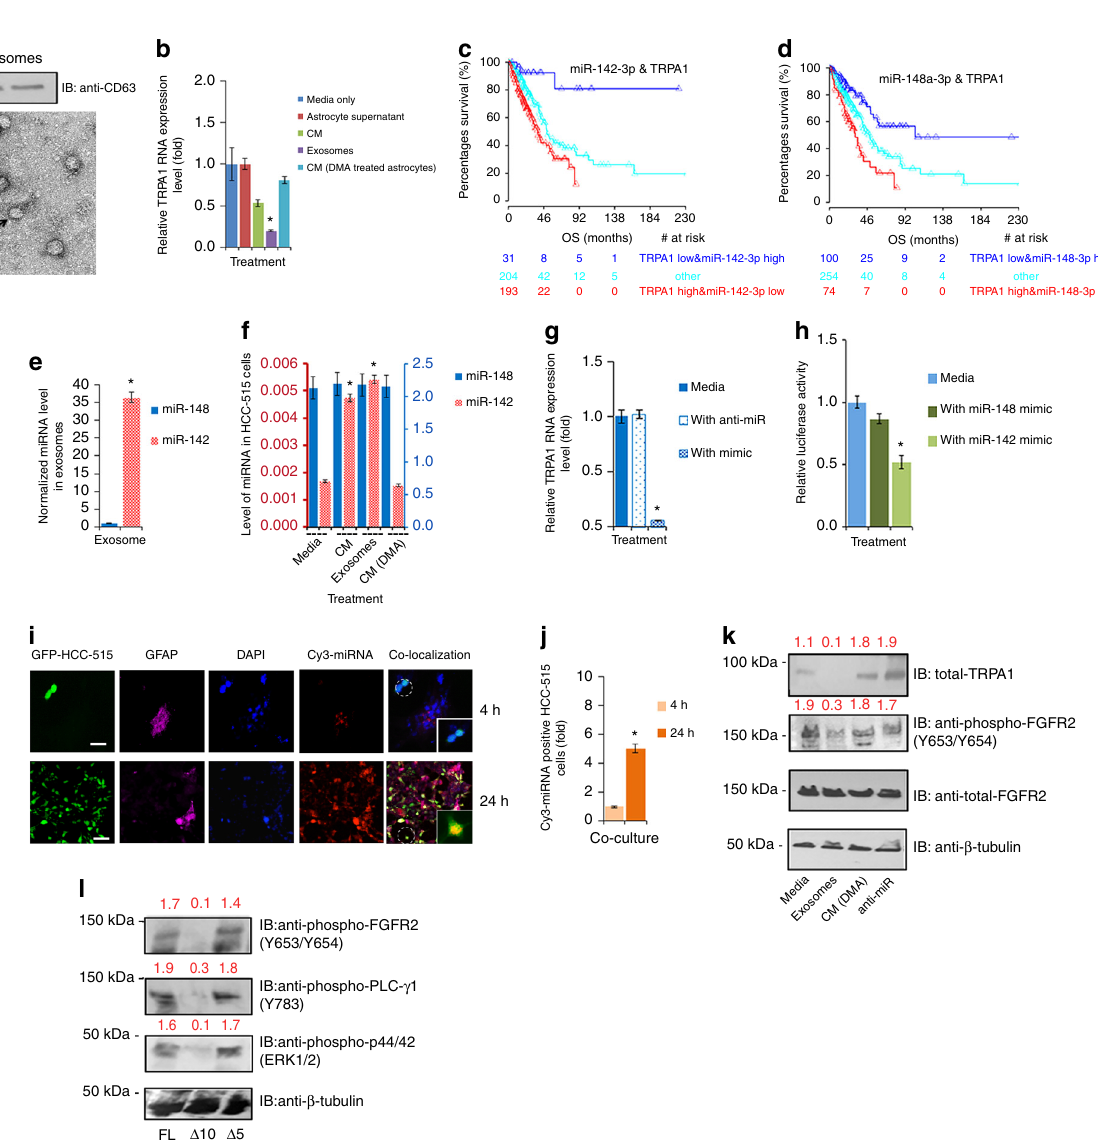
Fig. 6 TRPA1-targeting miR-142-3p is intercellularly transferred from astrocytes to HCC-515 cells. a TEM image (Scale bar: 50 nm) and western blot analysis (loaded samples are from two separate experiments) of puri fi ed exosomes. The blot was probed with CD63 antibody. b Bar graph depicting normalized TRPA1 mRNA level in HCC-515 cells treated overnight with SS media (normalization control), astrocyte supernatant, which lacks exosomes, astrocyte-CM, 200 μ l of 100X concentrated exosomes and CM from astrocytes that have been treated for 4 h with DMA (inhibitor of exosomal release). c , d Kaplan – Meier curve depicting the correlation of TRPA1, miR-142-3p, and miR-148-3p with patient survival. The numbers of patients at risk at different time points are presented at the bottom of the graph. The calculated log-rank test value yielded P = 0.00001 ( c ) and P = 0.00002 ( d ), respectively. The median of overall survival (OS) in months is shown. e , f Bar graphs showing the level of miRNA in exosomes and differentially treated HCC-515 cells. g Bar graph representation of the changes in TRPA1 mRNA levels in HCC-515 cells following their treatment with SS media only, SS media + anti-miR (miR-142- 3p inhibitor) and SS media+ miR-142-3p mimic. h Bar graph of the 3 ′ -UTR luciferase assay results obtained from HEK 293T cells in the abence or presence of mimics. i IF staining images of the intercellular transfer of miR-142-3p, 4 h or 24 h following the co-culture of HCC-515 (expressing an empty GFP vector) with astrocytes that have been loaded with Cy-3-labeled miR142-3p. GFAP (Alexa 647 with magenta as a pseudo-colour) was utilized as an astrocytic marker to distinguish them from cancer cells. Scale bar is 50 μ m. j Bar graph representation of the results from i ) counted at 20× magni fi cation in eight randomly selected microscopic fi elds. k Western blot analysis of HCC-515 after variable overnight treatments followed by probing with the indicated antibodies. Normalized densitometric values represent the average of three independent experiments. l Western blot analysis of HCC-515 cells 6 h post- transfection with the indicated constructs following their overnight treatment with exosomes. The blot was probed with the indicated antibodies. In the above, error bars, s.d. ( n = 3 biological replicates). * P ≤ 0.05 and ** P ≤ 0.01 by two-tailed Student ’ s t